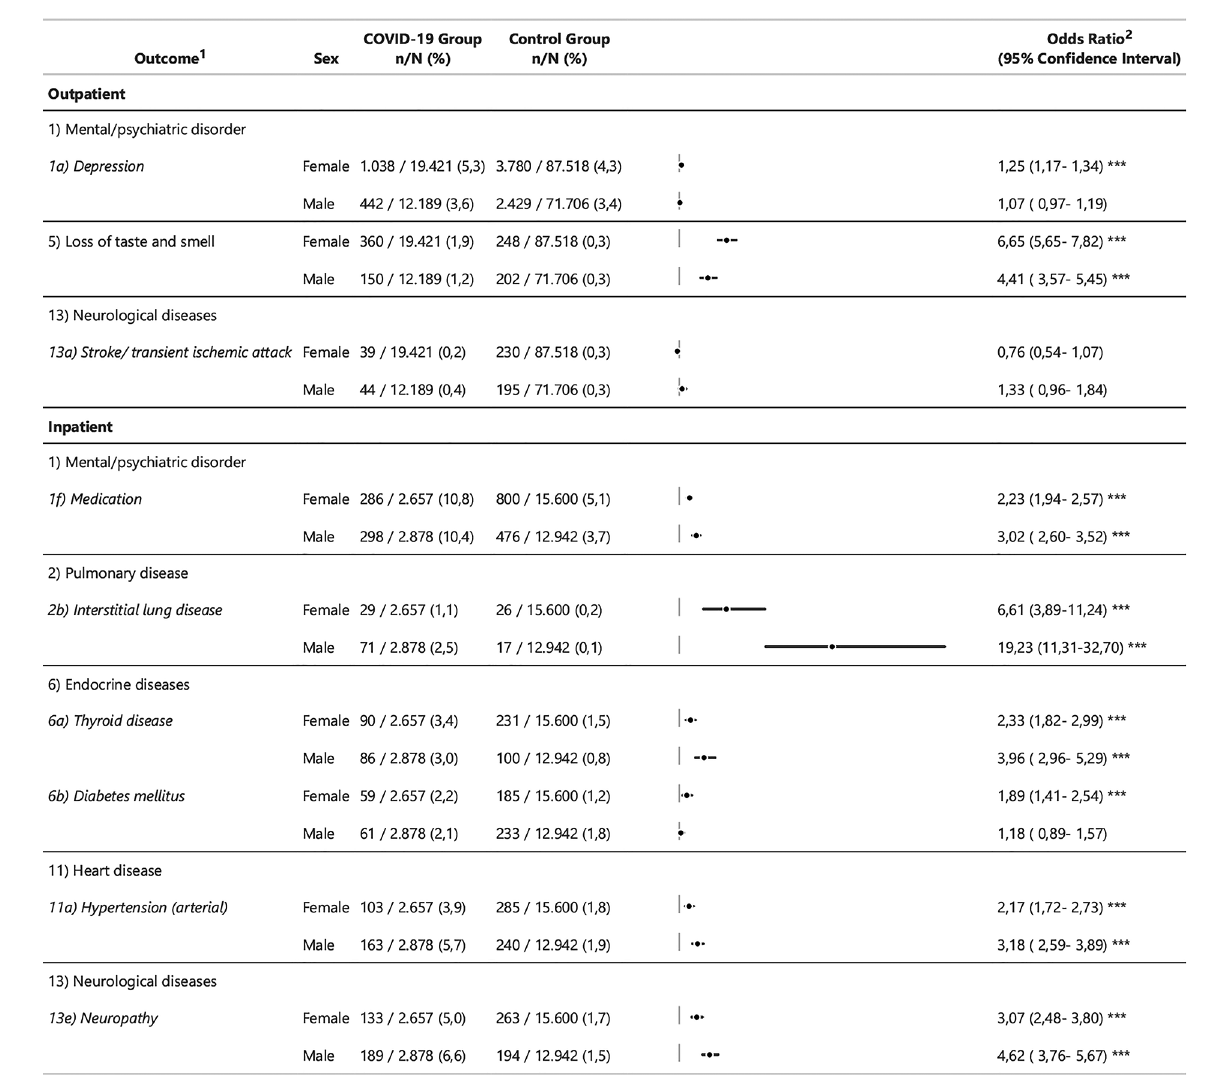
FIGURE 4 Descriptive results and odds ratios of outcome variables showing signi fi cant sex differences in the outpatient and the inpatient sample. 1 Operationalisation of the outcome variables is described in the supplement 1. 2 OR=Odds Ratio; CI=Con fi dence Interval; * p <=0.05; ** p <=0.01; *** p <=0.001; n.a.=not assessed when value <10 (also within the sex